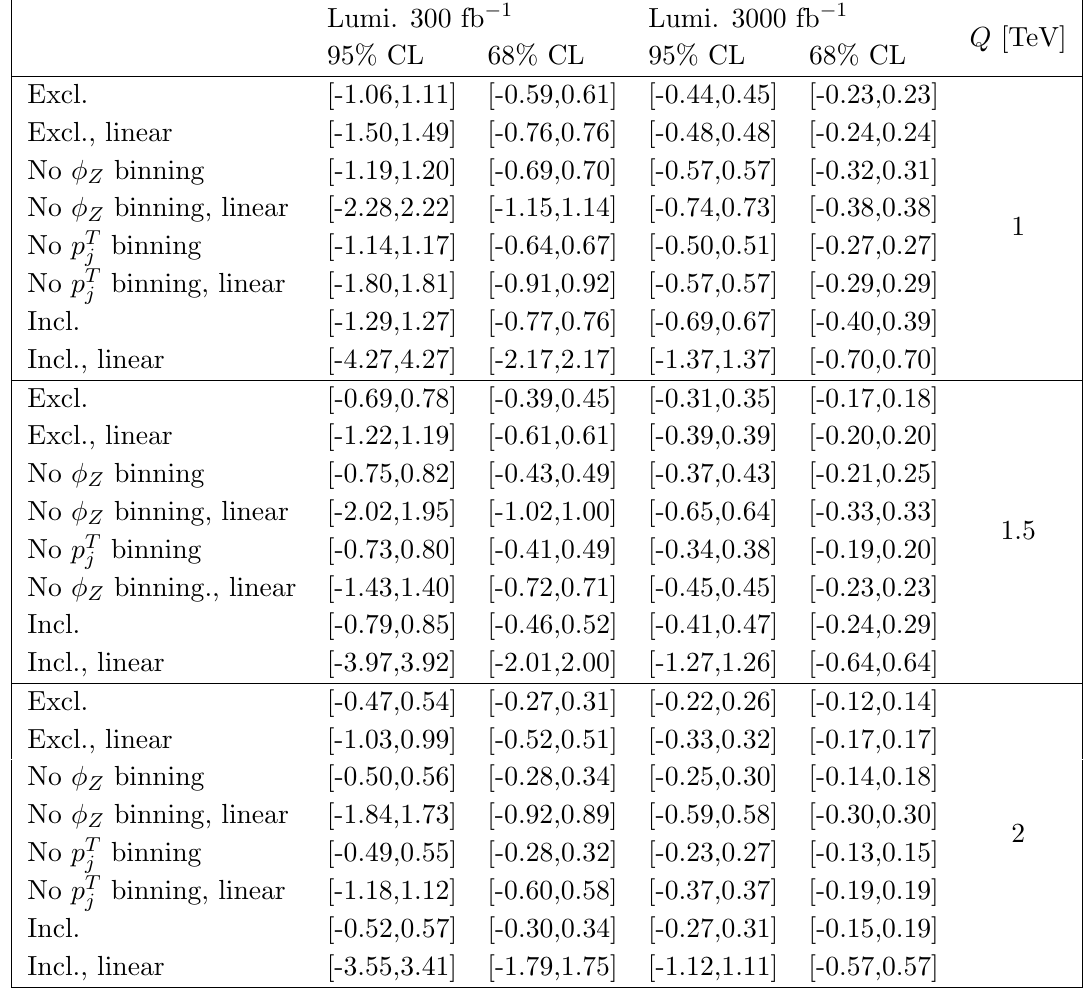
Table 3 . Bounds on c 3 W = (cid:3) 2 (cid:2) TeV 2 . The total leakage in the various bins of m T